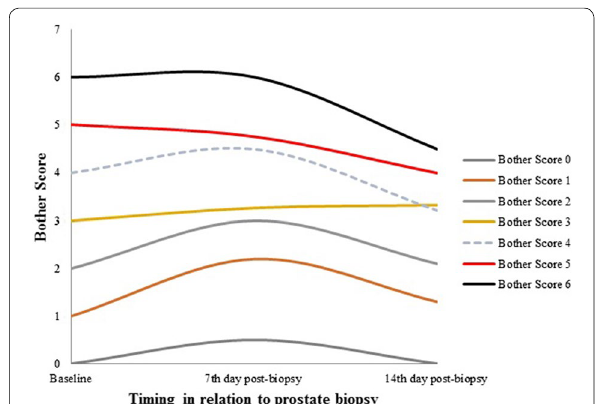
Fig. 1 Line diagram showing trends in the 7th and 14th day average bother scores at different baseline bother scores in patients